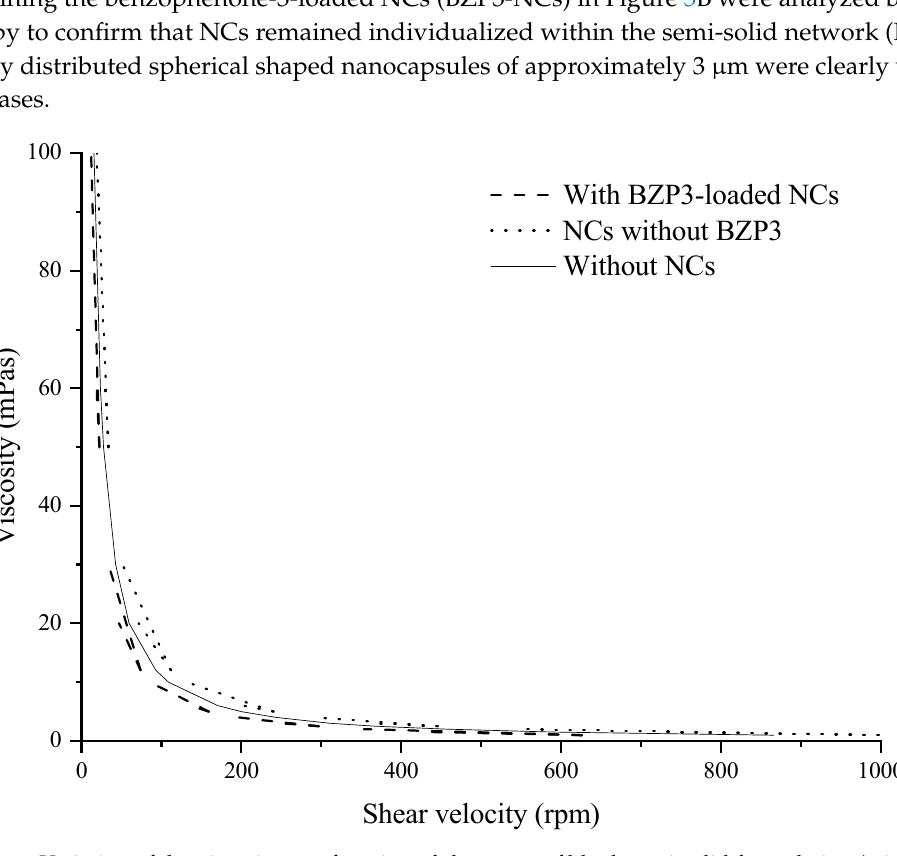
Figure 3. Variation of the viscosity as a function of shear rate of blank semi-solid formulation (without NCs), semi-solid formulation with blank NCs (NCs without BZP3) and semi-solid sunscreen (with BZP3-loaded NCs).